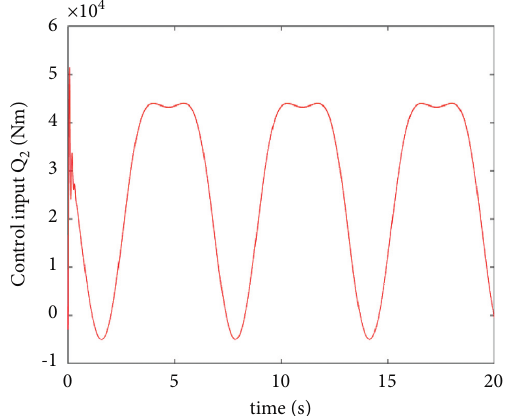
Figure 11: The regulation of generalized force Q